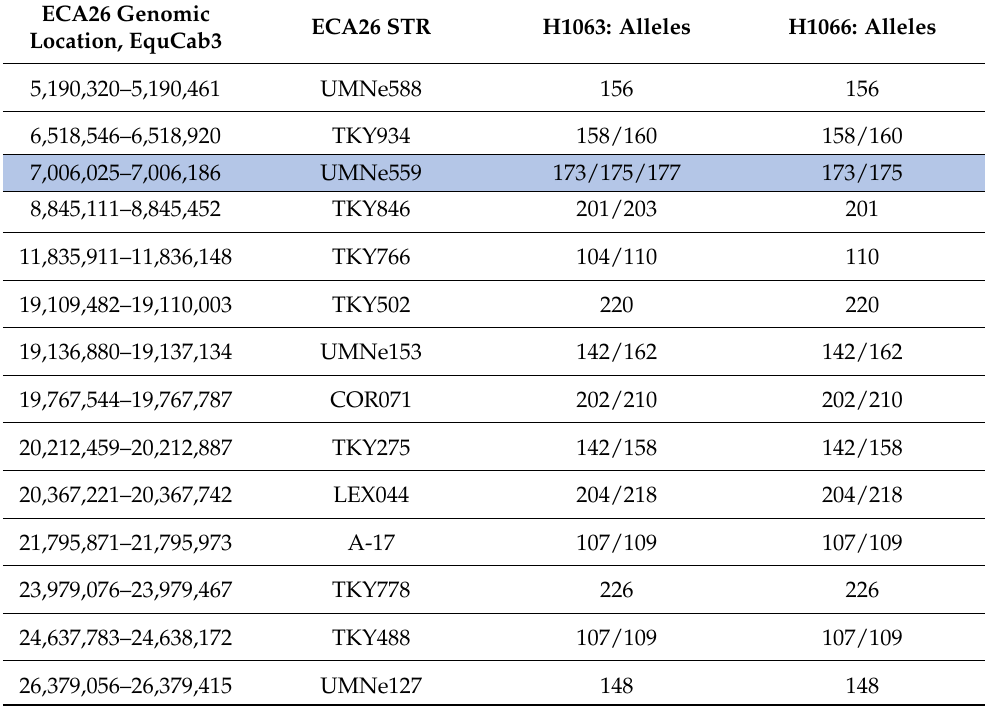
Table 3. Genotyping results with ECA26 STRs. Markers are presented according to their linear order from centromere to telomere in ECA26; markers with three alleles in the foal are highlighted. ECA26 Genomic ECA26 STR H1063: Alleles H1066: Location, EquCab3